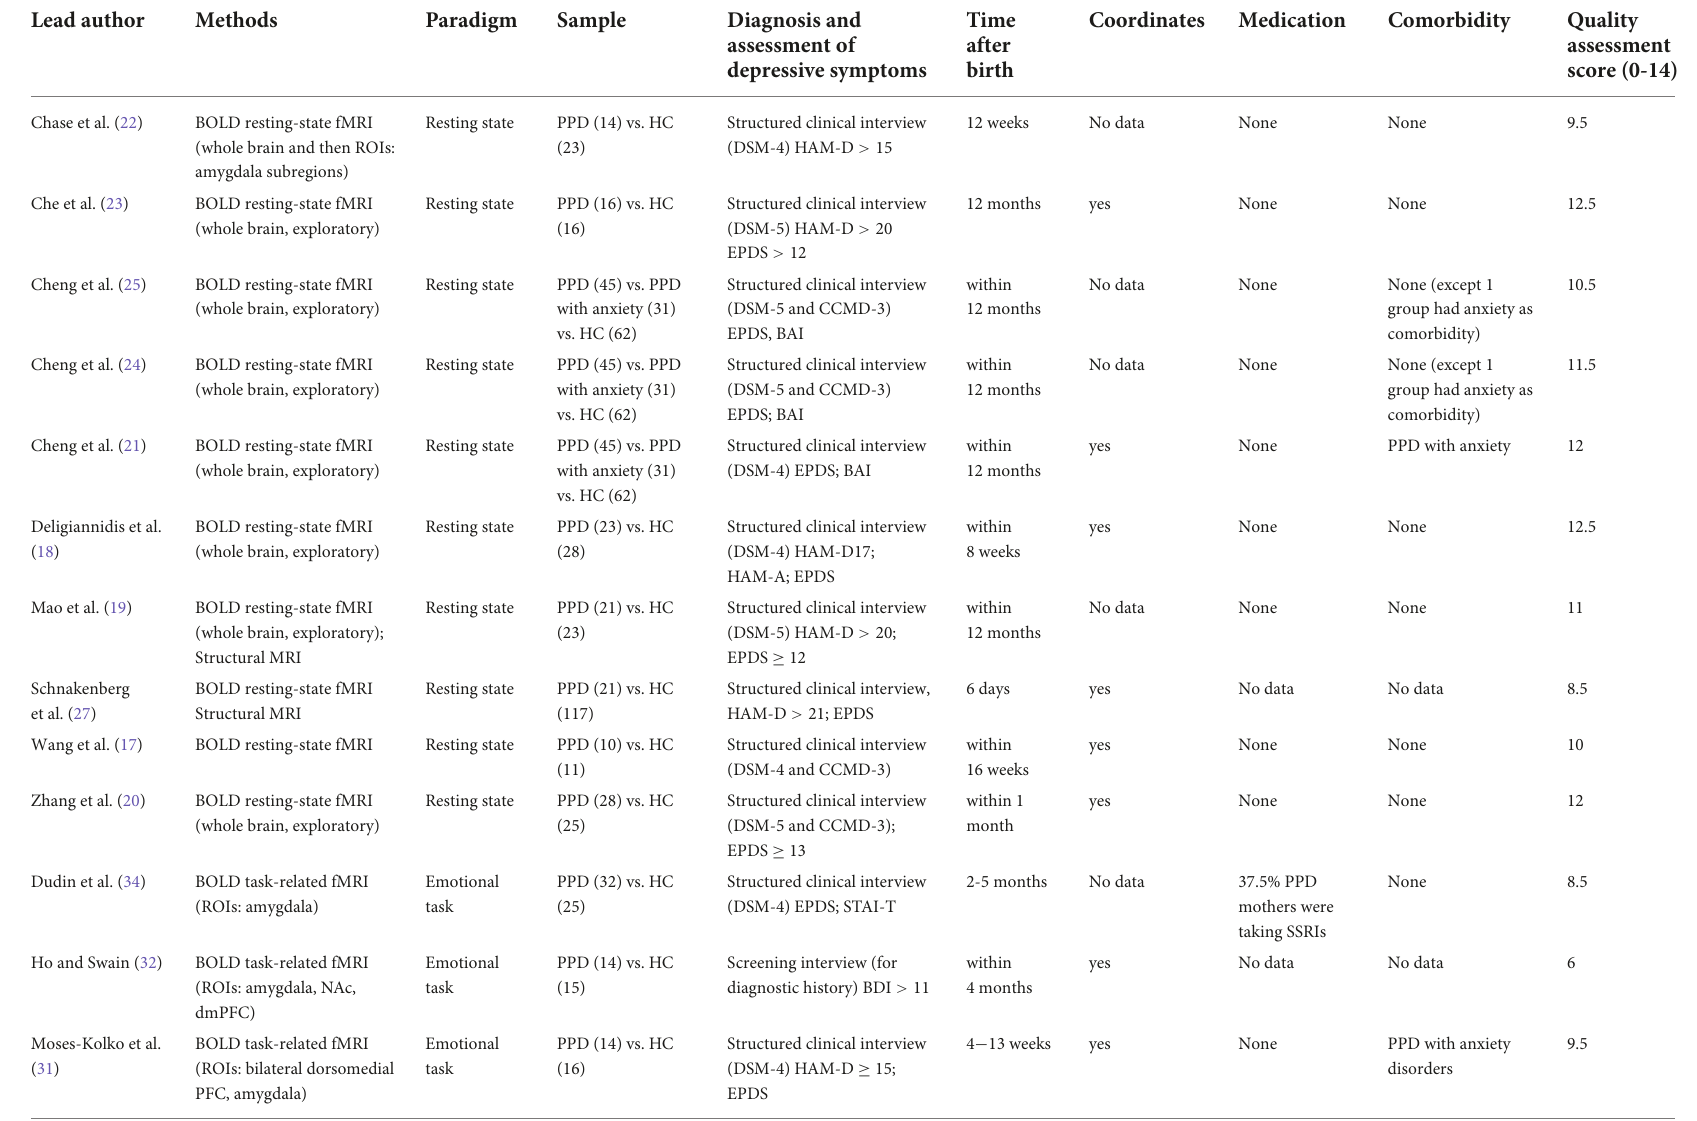
TABLE 1 Data extraction of functional magnetic resonance